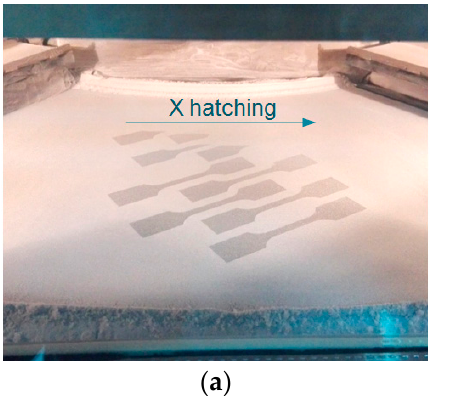
Figure 5. Images from sinterization process for 45° orientation of the samples. ( a ) hatching of layer k in X direction; ( b ) hatching of layer k+1 in Y direction of the machine.